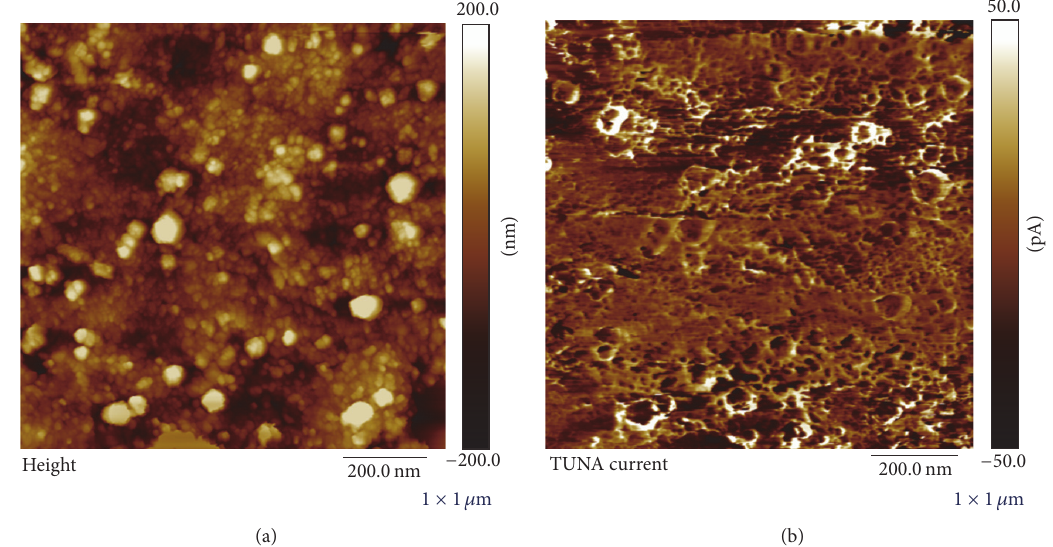
Figure 6: Simultaneous mapping of (a) topography and (b) current of Mn-PPy240/G electrodeposit obtained with PeakForce TUNA.